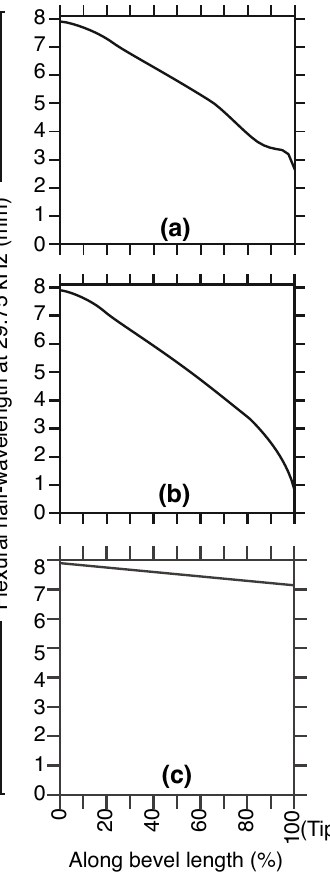
Along bevel length (%) Figure 7. FEM studies at 29.75 kHz and application of Eq. (1) in calculation of the variation of flexural half- wavelength ( (cid:31) y / 2 ) for the lancet ( a ), a-symmetric ( b ) and axi-symmetric ( c ) bevel geometries (as introduced in Fig. 1a,b,c). Mean (cid:31) y / 2 was 5.65, 5.17, and 7.52 mm for the lancet, a-symmetric, and axi-symmetric bevels, respectively. Note the tip thickness of a-symmetric and axi-symmetric bevels was limited to